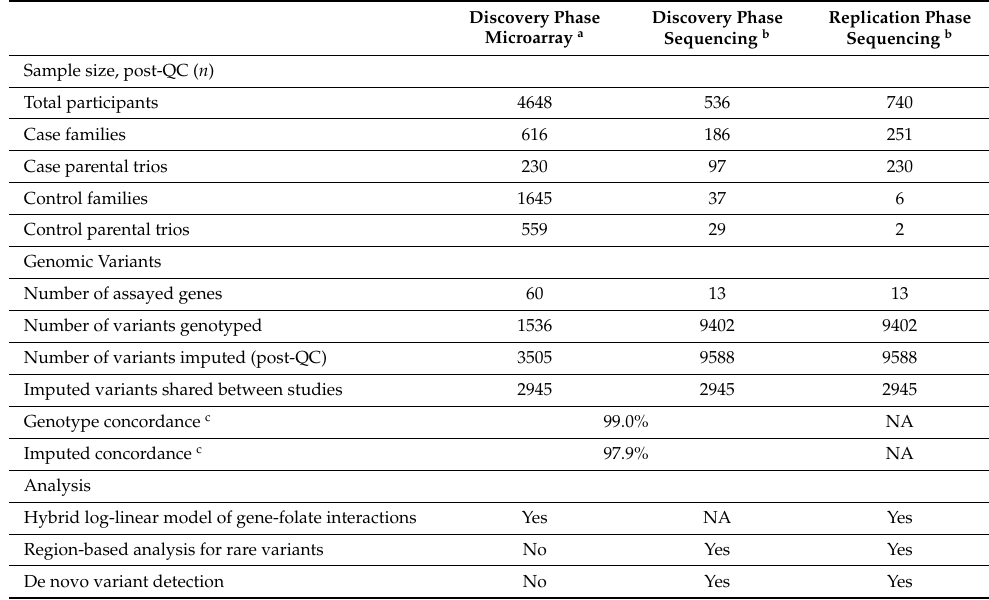
Table 1. Comparison of discovery and replication